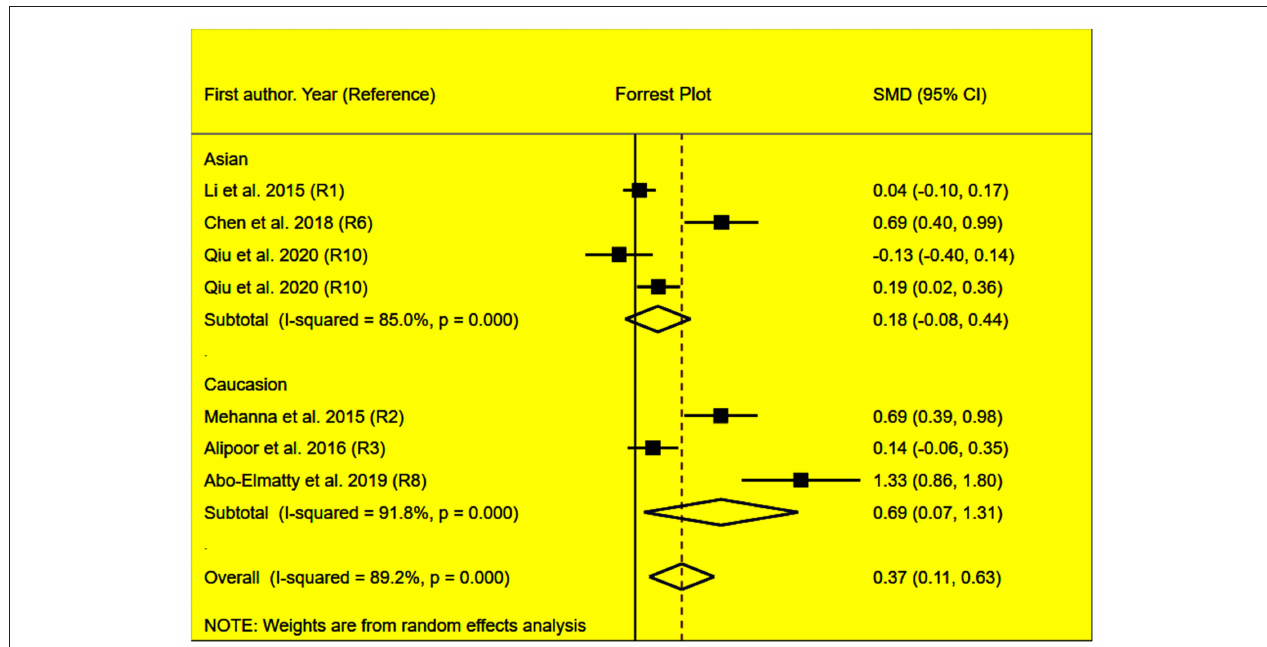
FIGURE 4 | Forest plot of the meta-analysis between miRNA-146a rs2910164 polymorphism and plasma LDL-C levels.